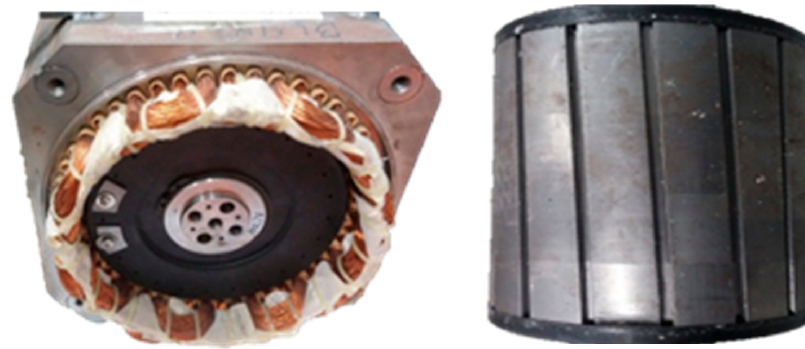
Figure 23. Rotors and stators of the prototype built for Qs48p8.